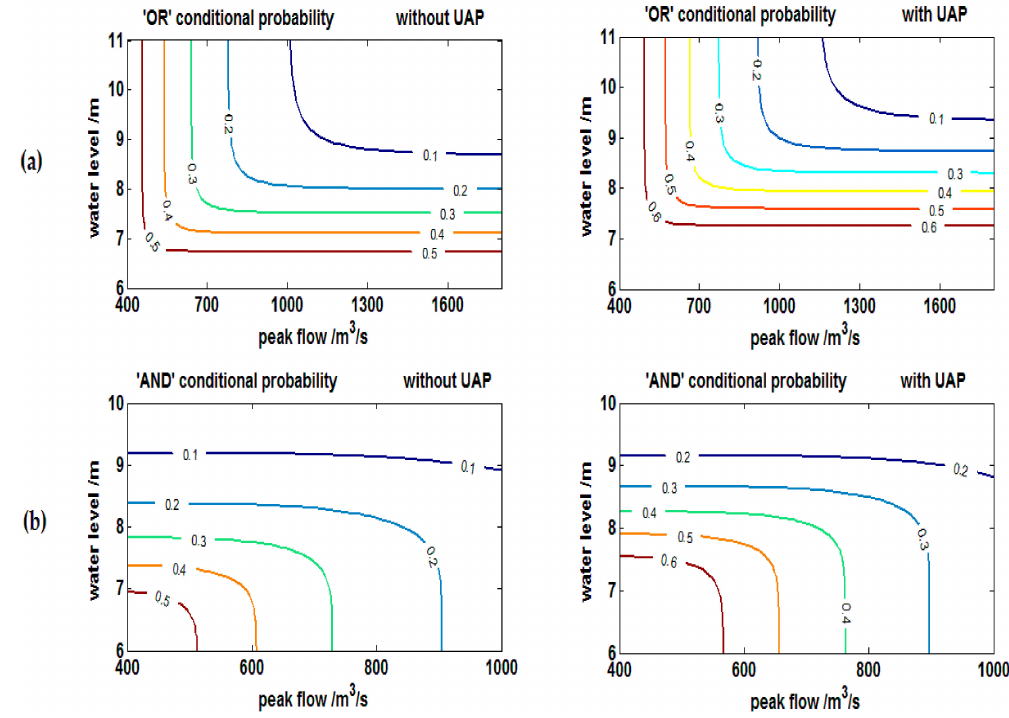
Figure 6. Two conditional probability contours of flood volume <300 m 3 : ( a ) ‘OR’ conditional probability contour of flood volume <300 m 3 ; ( b ) ‘AND’ conditional probability contour of flood volume <300 m 3 .